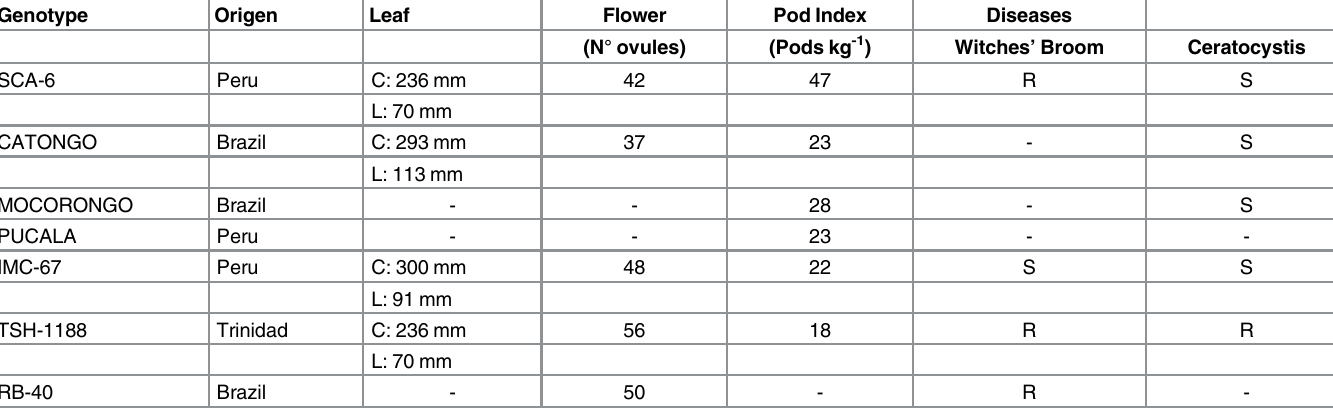
Table 1. T . cacao genotypes used in diallel crosses and its main characteristics. Genotype